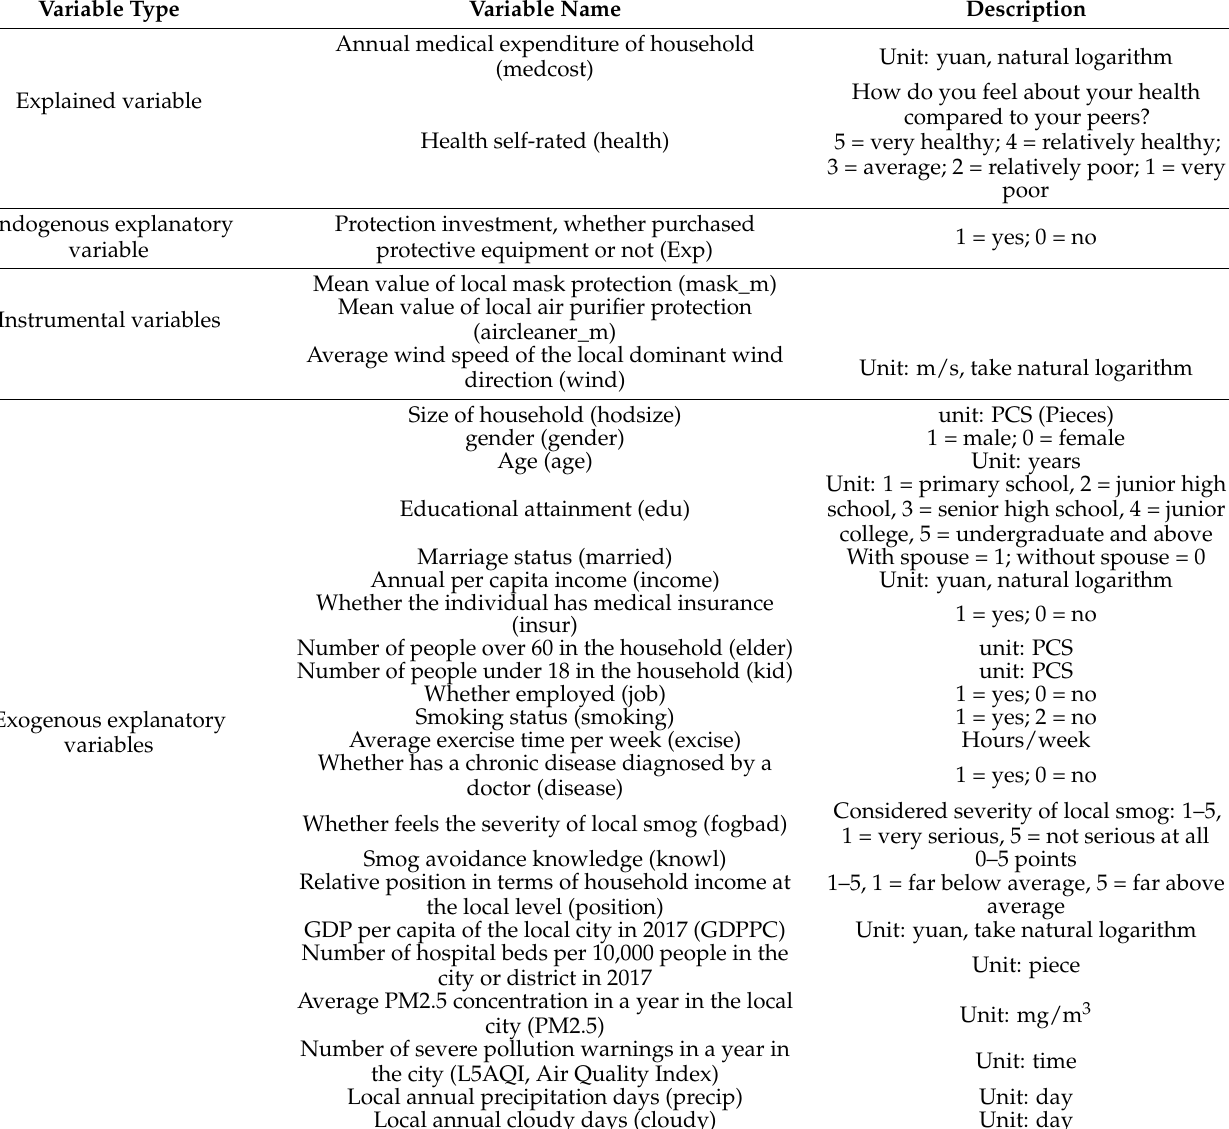
Table 2. Description of